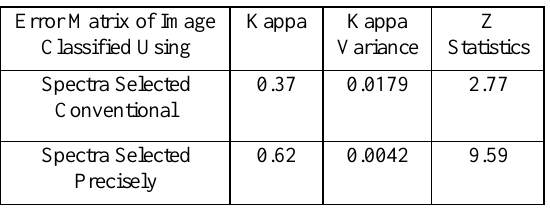
Table 13: Kappa Analysis Results for the Pairwise Comparison of the Error Matrices Pairwise Comparison between